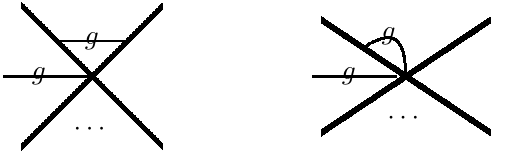
Figure 13 . Diagrams where the external graviton attaches to the n -point vertex. The (cid:12)rst diagram vanishes if we take the external graviton polarization to be traceless. The second diagram has no logarithmic terms.